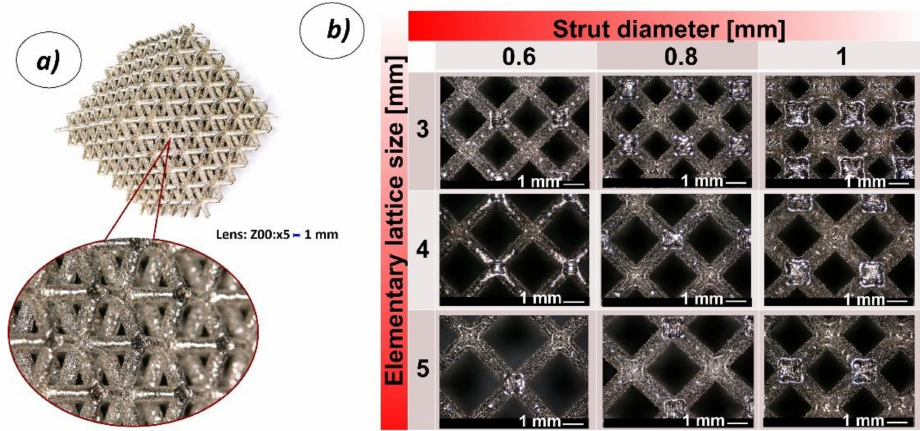
Figure 4. View of a lattice structure specimen made additively with the use of the selective laser melting (SLM) 3D printing technique; a ) isometric view of the structure, b ) detailed views of elementary unit cells (3, 4, 5 refer to the dimensions of the elementary cell size; 0.6, 0.8, 1 refer to the strut